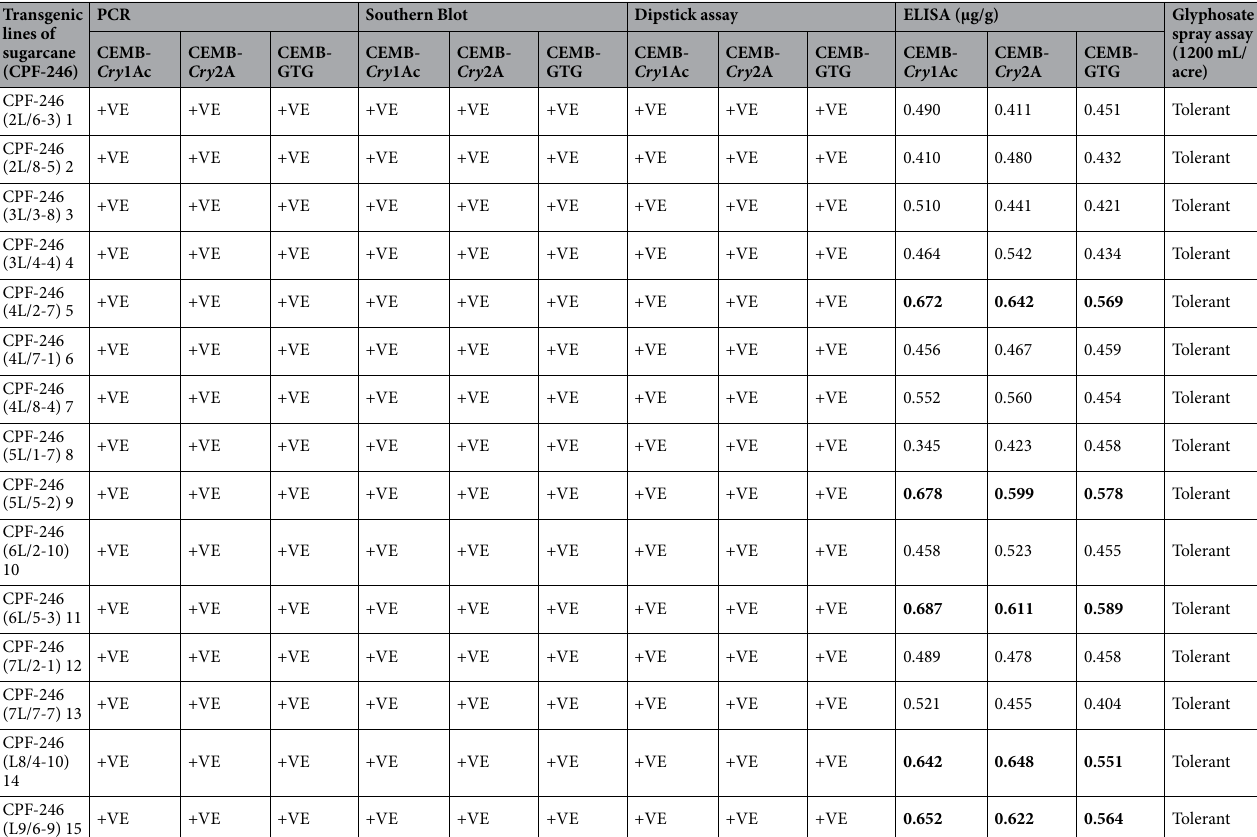
Table 4. Summary of molecular analysis of randomly selected transgenic sugarcane plants (V 1 -generation). Bold values indicate higher protein